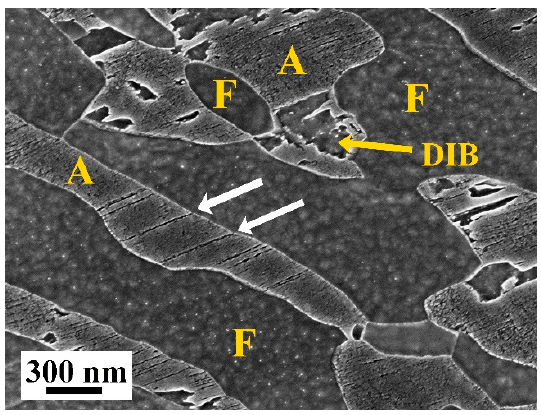
Figure 8. ( a ) SEM micrograph and ( b ) EBSD phase map showing the formation of DIBs in a specimen tested at 200 °C to an elongation of 30%. Note the high indexing hit rate of EBSD phase map. F: ferrite, A: austenite. Blue color represents fcc phase, red color represents bcc phase, and black color represents unindexed points. White stars are registration marks.